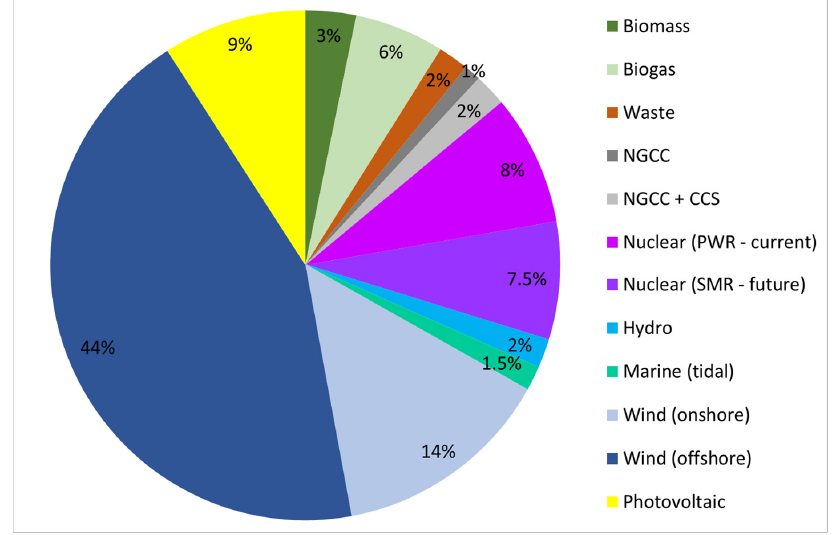
Figure 2. Expected UK grid mix composition in 2035, in terms of total electricity generated (under “2 degrees” scenario assumptions). NGCC = natural gas combined cycles; NGCC + CCS = natural gas combined cycles plus carbon capture and storage; PWR = pressure water reactors; SMR = small modular reactors.